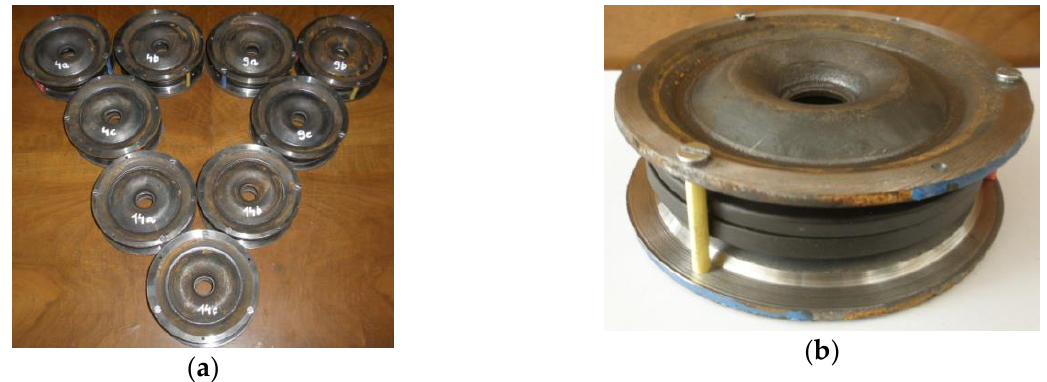
Figure 6 . Mechanical force sensors designed for the rock bolt support: (a) General view; (b) Detailed view.